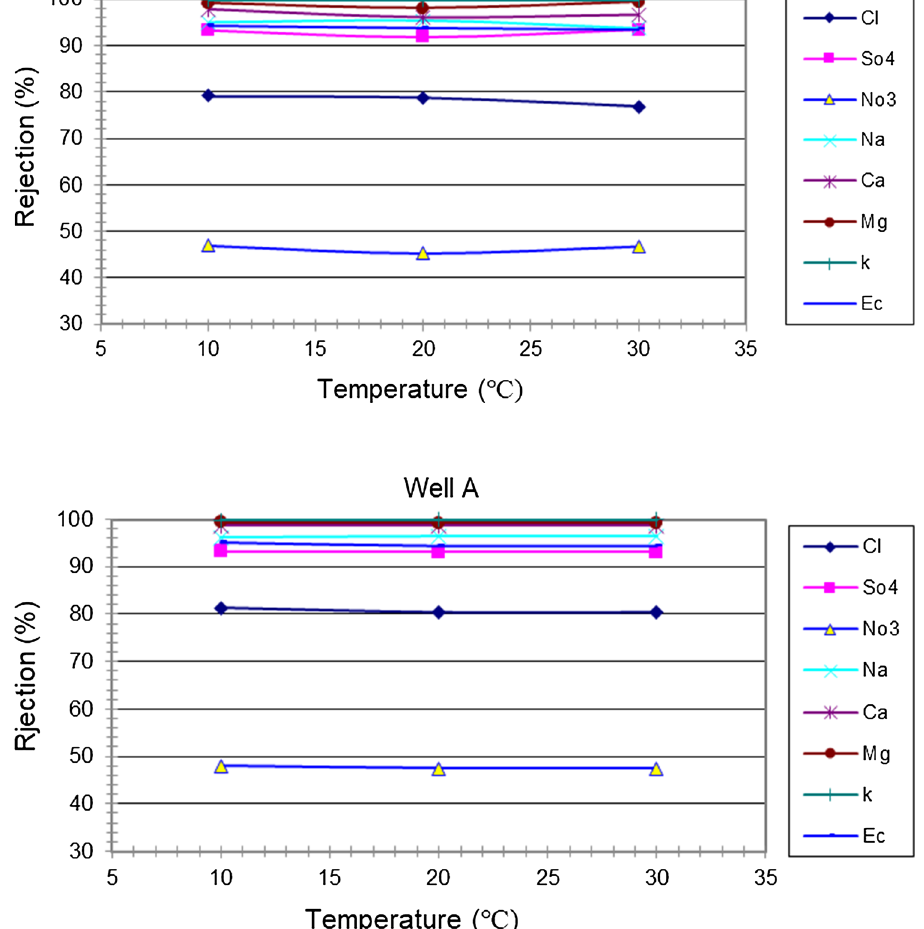
Fig. 5 Rejection rate of ions versus temperature (pressure: 4 bar)